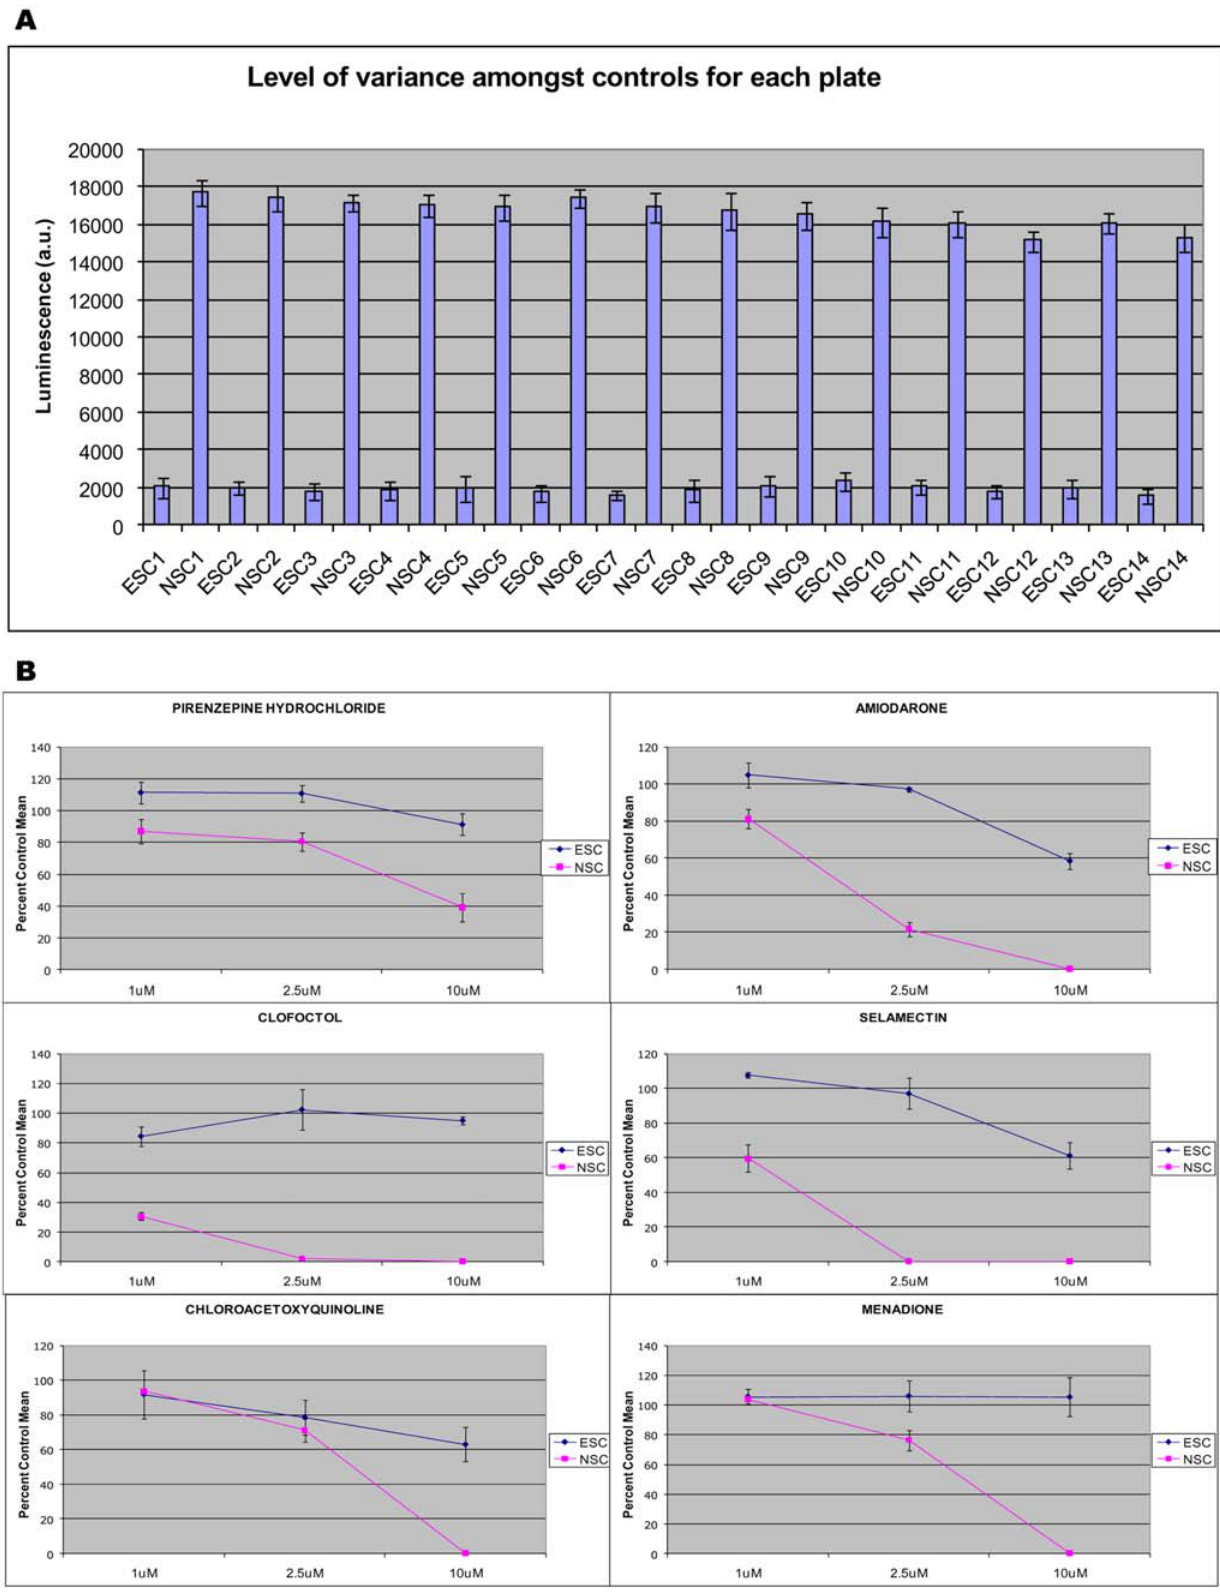
Figure 2.Primary screensand retests withthe NINDScollection. ( A ) ATPlevels inhESCs andNSCs. (B) Dose responseofNSCand hESC toselectively screened NINDS compounds. Hits obtained in the primary screen were retested and validated to be toxic to NSCs in a dose-responsive manner.